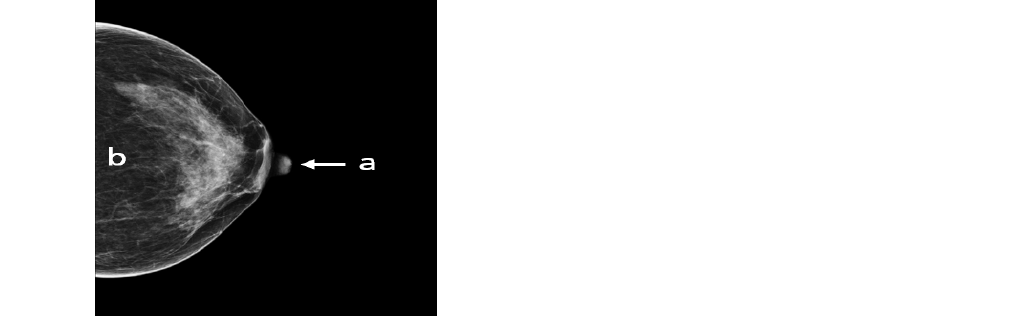
Figure 7. An adequate CC view with (a) nipple in profile and centered, (b) visualized retroglandular fat.